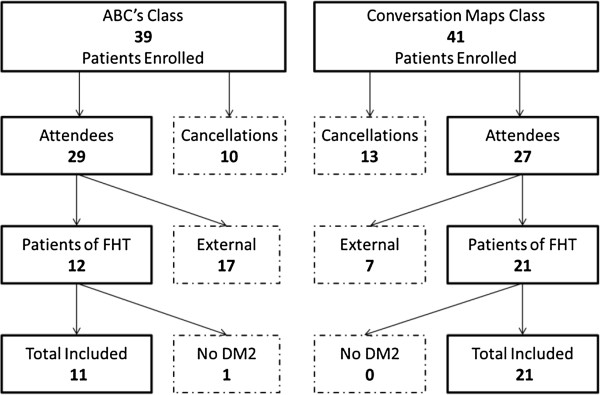
Flow diagram of patient inclusion. ABC’s = ‘ABC’s of Diabetes’, FHT = Riverside and Melrose Family Health Teams, DM2 = type 2 diabetes mellitus.